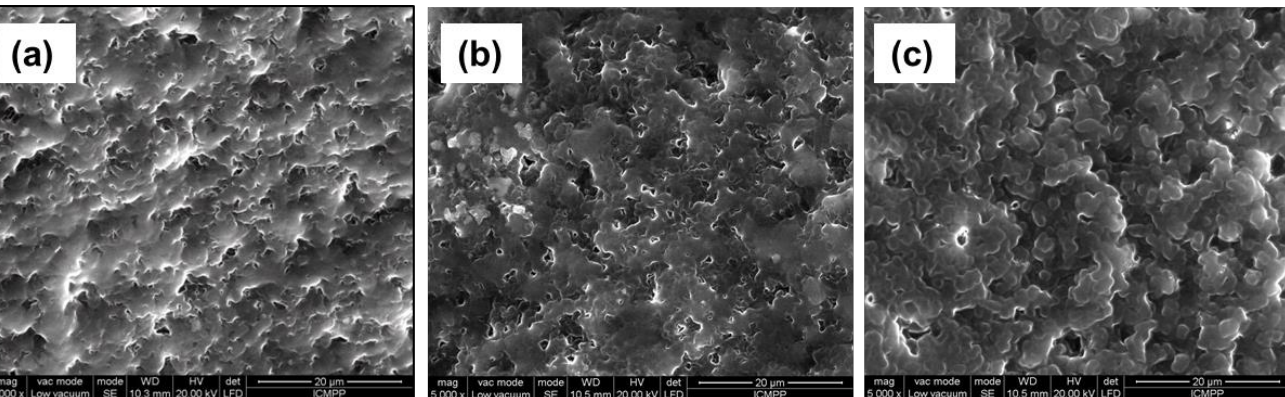
Figure 3. Influence of the chemical structure of the cross-linking agent on the maximum swelling degree in water.